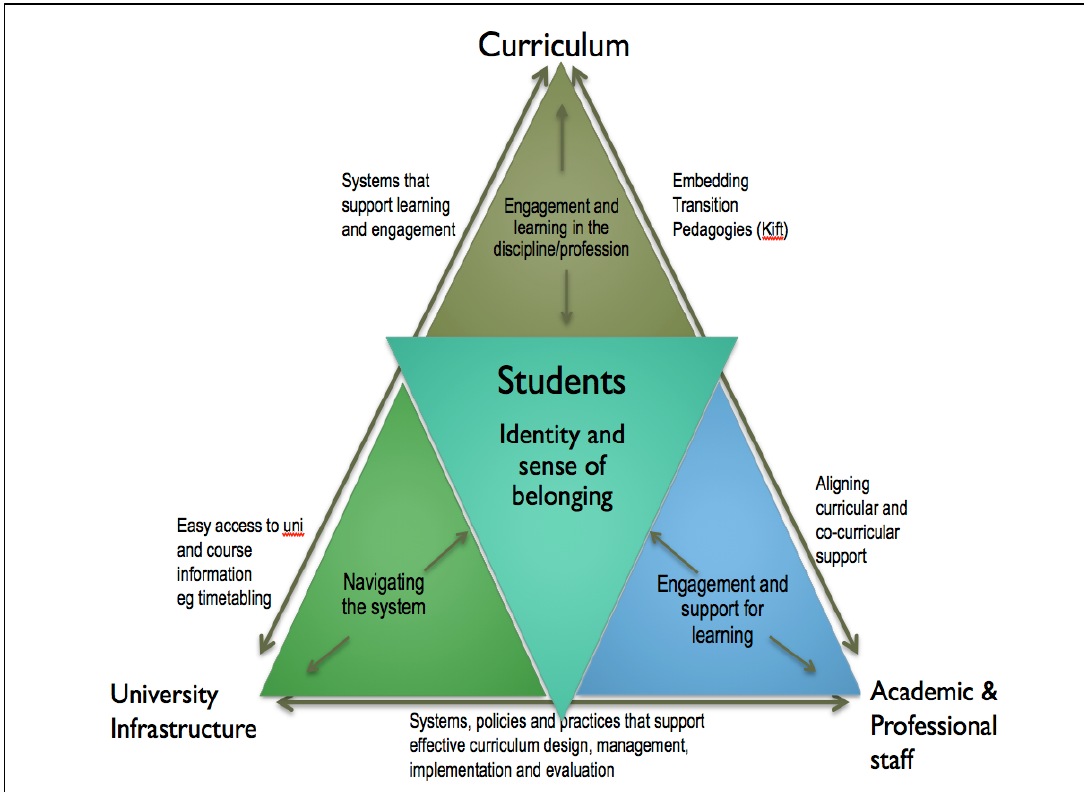
Figure 1: UTS FYE Program Strategy